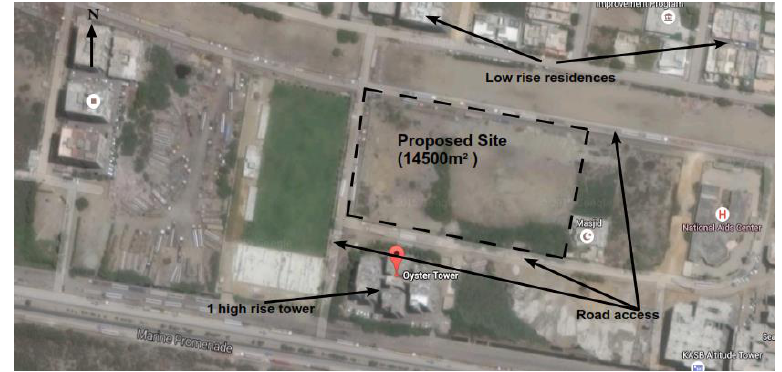
Fig. 2. Proposed site in Block 1, Clifton, Karachi, Pakistan. Source: Google Maps,